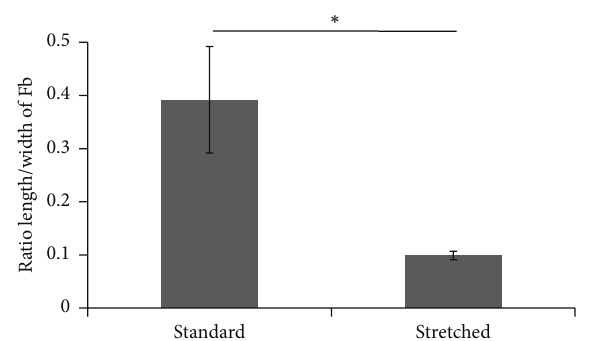
Figure 5: “Stretched” cell culture conditions flattened the cells embedded in the stroma. Masson’s trichrome stained slices of tissue were analyzed to determine the ratio between the maximal length and the maximal width of cells. Asterisks indicate when statistically significant differences were found (i.e., 𝑝 < 0.05